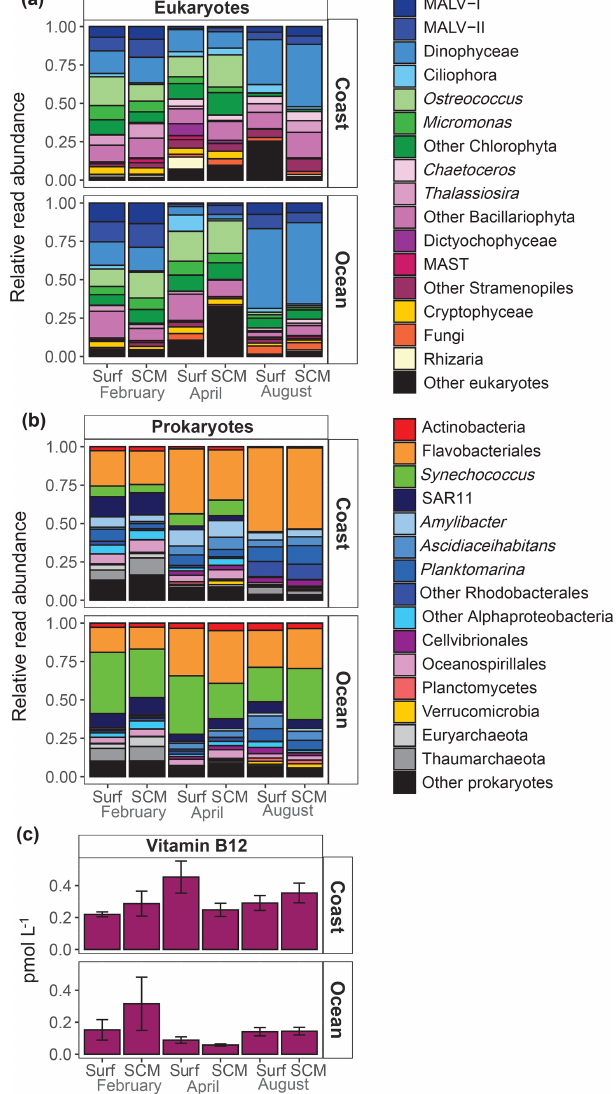
Figure 4. Averaged relative contribution of reads to the major taxo- nomic groups of (a) eukaryotes and (b) prokaryotes at surface (surf) and SCM depth in the coastal and oceanic stations in February, April and August. (c) Averaged B12 concentration (pmolL − 1 ) at surface (surf) and SCM depth in the coastal and oceanic stations in February, April and August. Error bars represent standard error. SCM refers to the subsurface chlorophyll